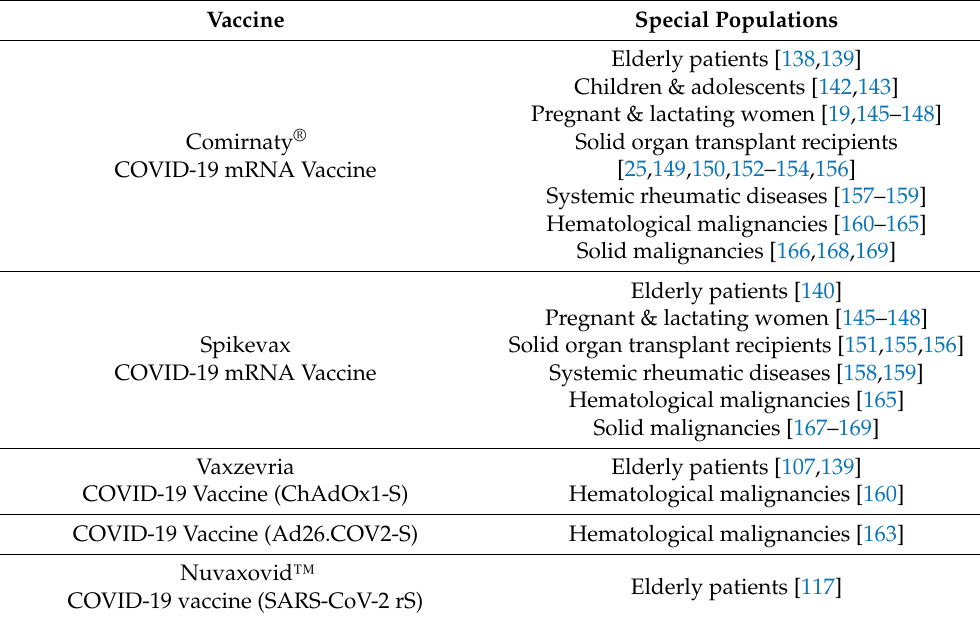
Table 2. The selected studies concerning effectiveness of European Medicines Agency and/or Food and Drug Administration authorized vaccines against COVID-19 in special patients